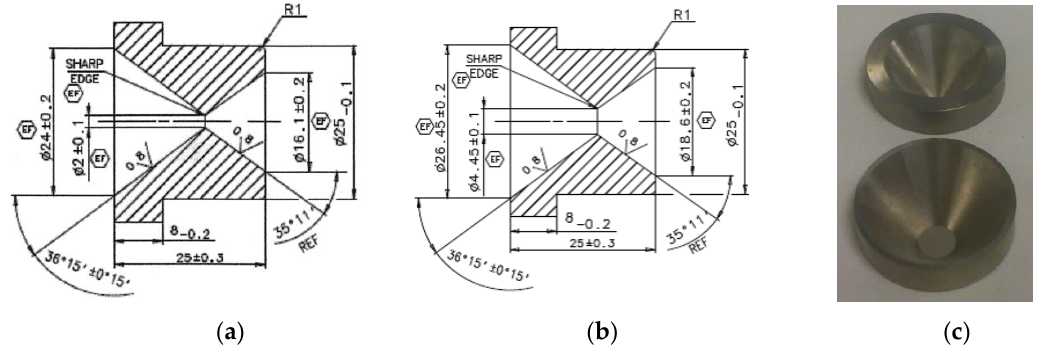
Figure 9. ( a ) The 2 mm pinhole insert design; ( b ) The 4.45 mm pinhole insert design; ( c ) The 2 mm pinhole insert (top) and the 4.45 mm pinhole insert (bottom), both made of tungsten.